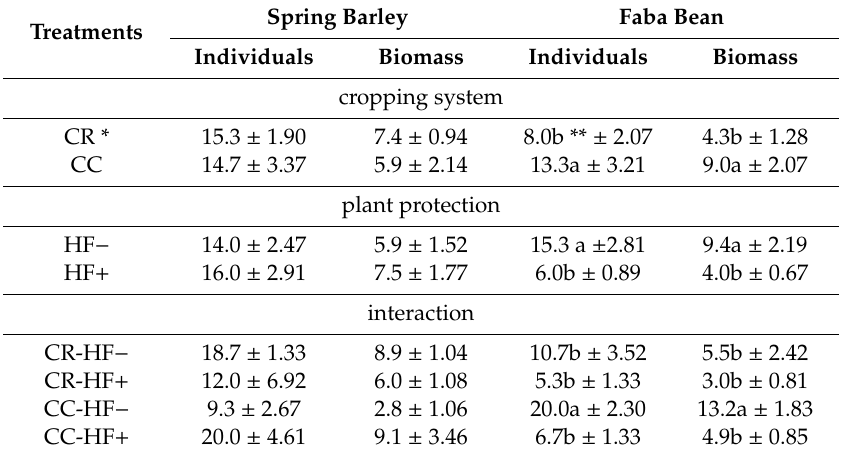
Table 5. Density (individuals m − 2 ) and biomass (g m − 2 ) of earthworms in spring barley and faba bean